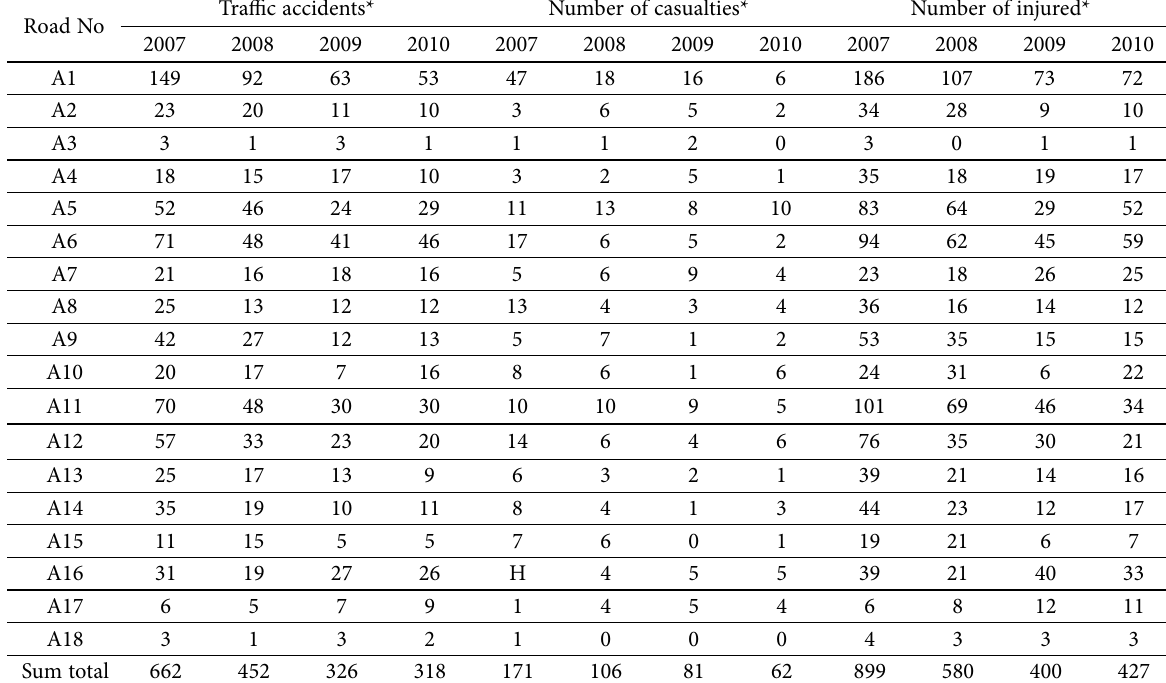
Table 3. Traffic accidents and victims of highways in